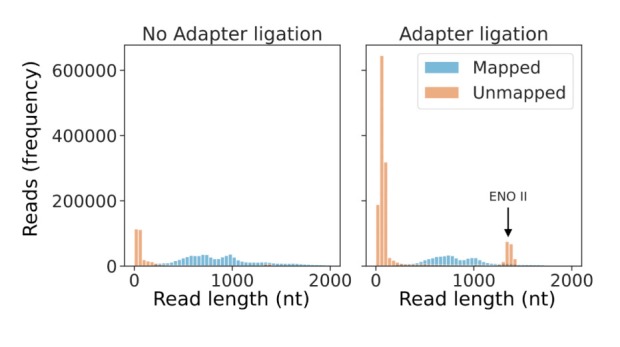
Low amounts of input RNA increase the number of Enolase II reads and short noise reads.Read length distribution of mapped (blue) and unmapped (orange) reads originating from a standard DRS experiment (left panel) and an adapter ligation experiment (right panel).